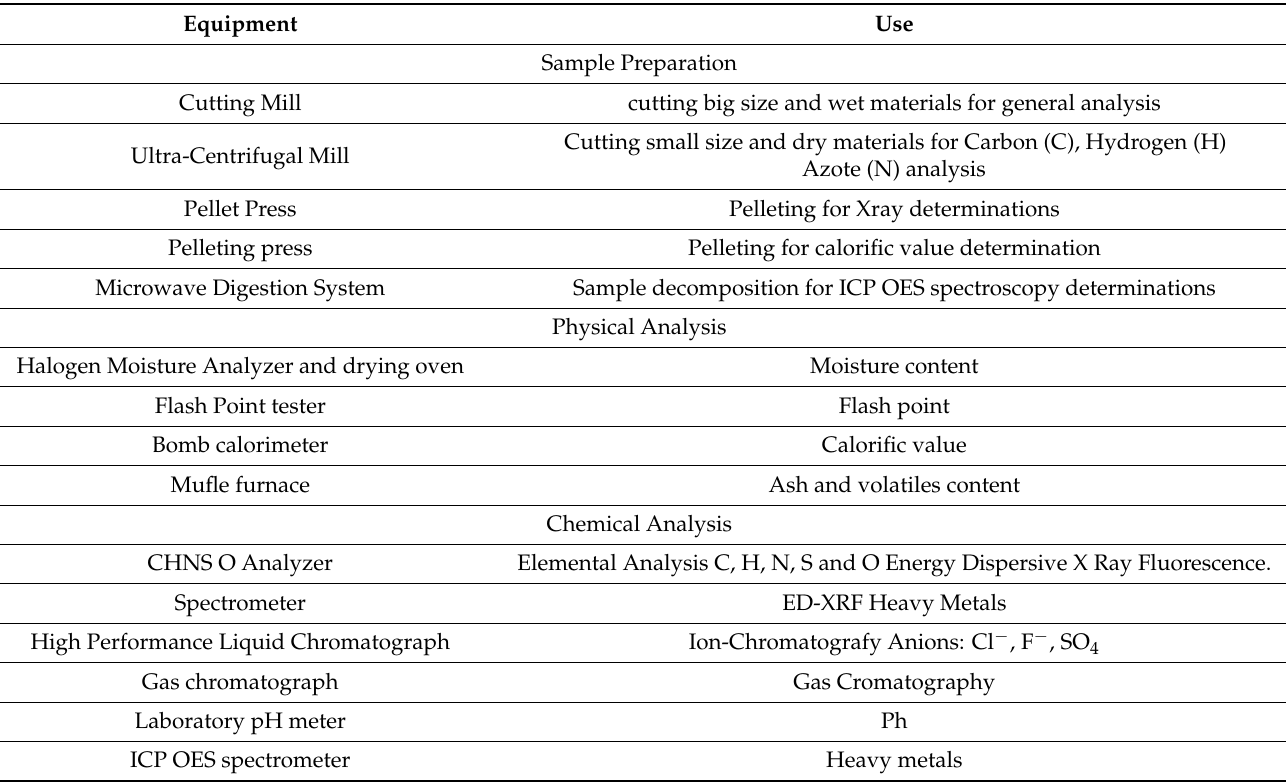
Table 5. Appropriate laboratory equipment and